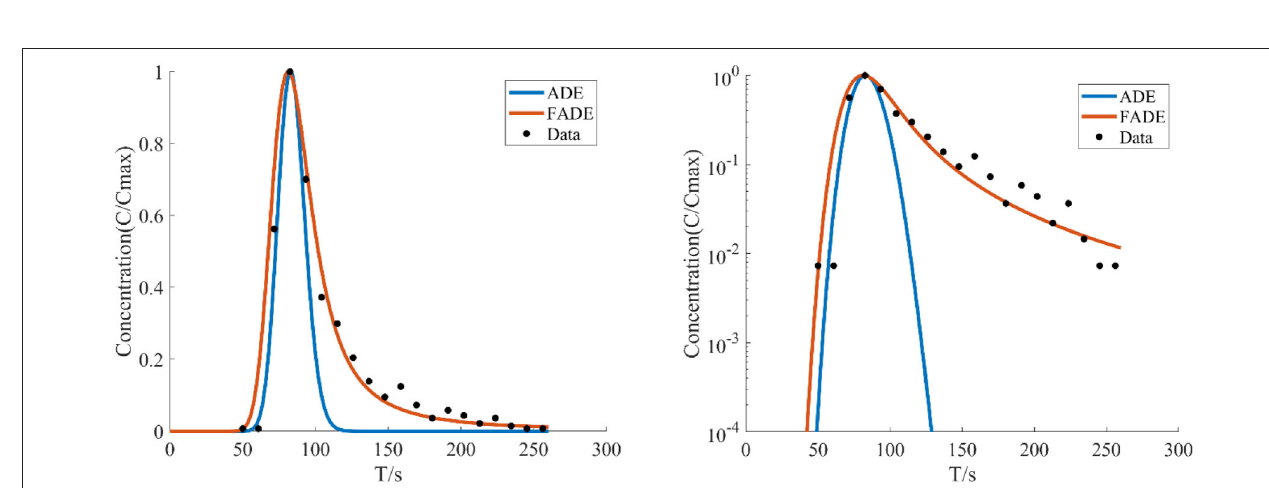
FIGURE 5 | The average flow rate is v = 9.02 mm/s, the crack width is B = 6mm, the BTCs are fitted by ADE model and FADE model.